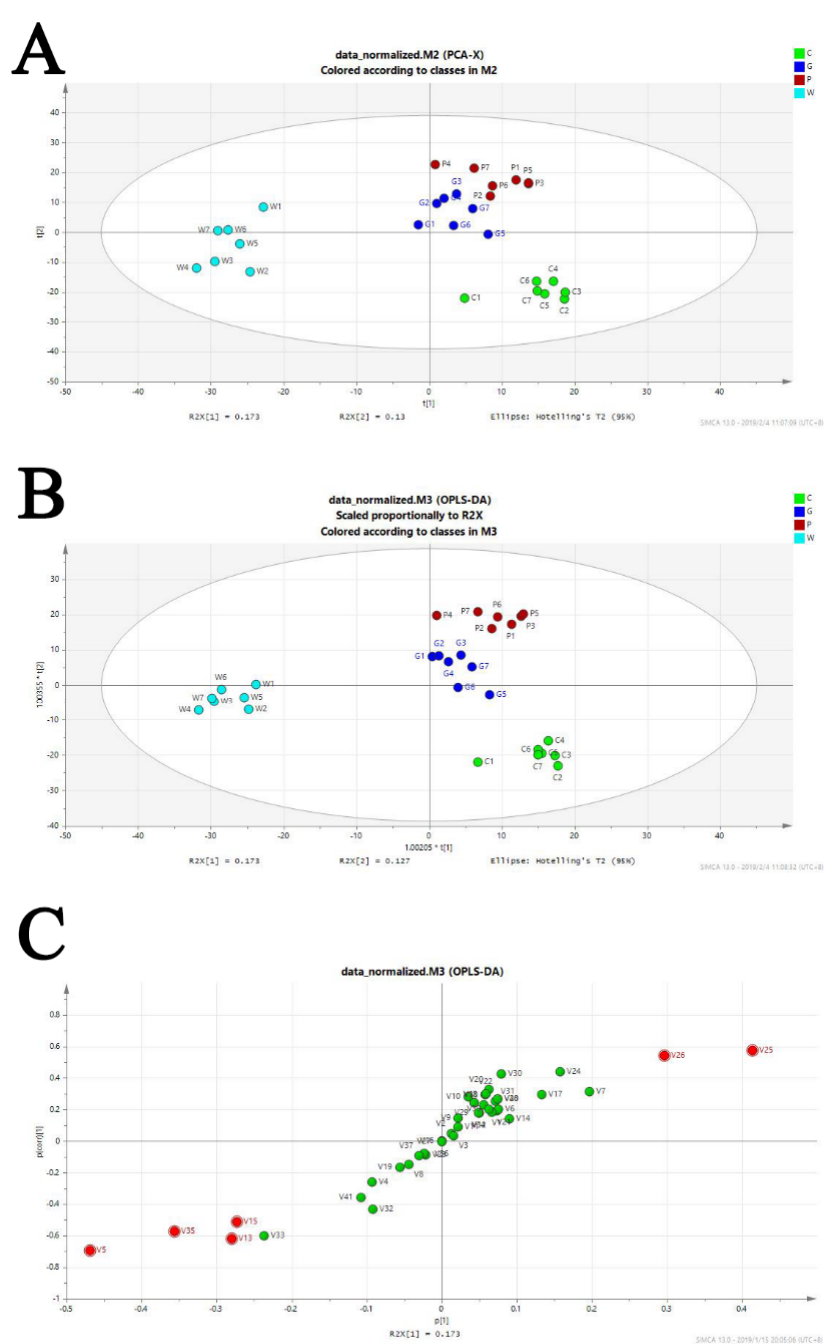
Figure 1. Discriminatory components of the crude and processed Curcuma zedoaria. ( A ) The score plots of the crude (G group for Curcuma kwangsiensis S. G. Lee et C. F. Liang; W group for Curcuma wenyujin Y. H. Chen et C.Ling; P group for Curcuma phaeocaulis Val.) and the processed Curcuma zedoaria control (C group) from principal component analysis (PCA) in the ESI + mode for PC1 versus PC2. ( B ) Orthogonal partial least-squares discriminant analysis (OPLS-DA) of the data derived from the ESI + mode. OPLS-DA score plots for the pair-wise comparisons of these four groups. ( C ) S-plot of the OPLS-DA model for these four groups. The points in red indicate the identified markers. Table 1. Discriminatory components of the crude and the processed Curcuma zedoaria.